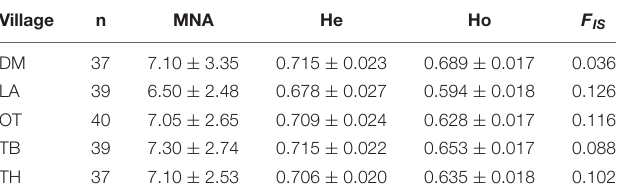
TABLE 3 | Mean number of alleles per locus (MNA), expected heterozygosity (He), observed heterozygosity (Ho), and average inbreeding coefficient ( F IS ) estimated from the 20 microsatellite loci for each village population.